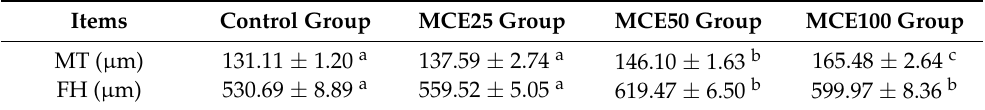
Figure 1. Effects of dietary Macleaya cordata extract (MCE) supplementation on the intestinal morphology of juvenile American eel. ( A ) Control group, ( B ) MCE25 group, ( C ) MCE50 group, and ( D ) MCE100 group (Magnification × 100). FH = fold height; MT = muscular thickness. Table 4. Effects of dietary MCE supplementation on the muscular thickness and fold height of intestine of the juvenile American eel.